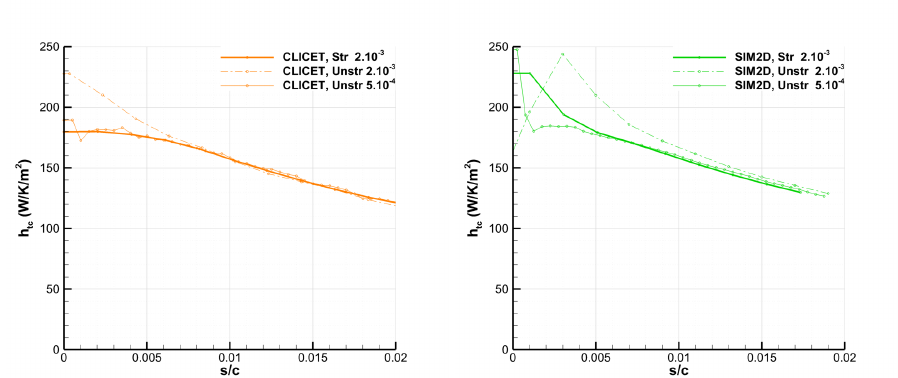
Figure A3. Solution produced by CLICET and SIM2D for the heat transfer coefficient in the laminar area of Han and Palacios’s experiment for several meshes. ( Left ): CLICET solution. ( Right ): SIM2D solution.